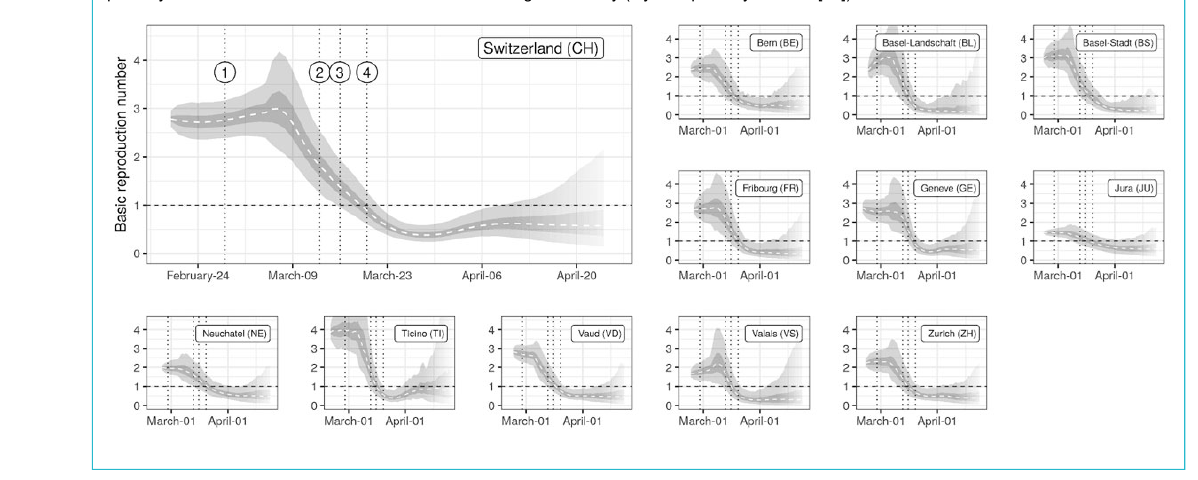
Figure 2: Estimates of changes in the basic reproduction number R 0 Median (dashed line), IQR (dark gray) and the 95% QR (light gray) of the estimated time series of R 0 are shown for each canton. Vertical dotted lines indicate the issuing of NPIs as described in figure 1. Trans- parency at the end of the time series indicates increasing uncertainty (style inspired by CMMID